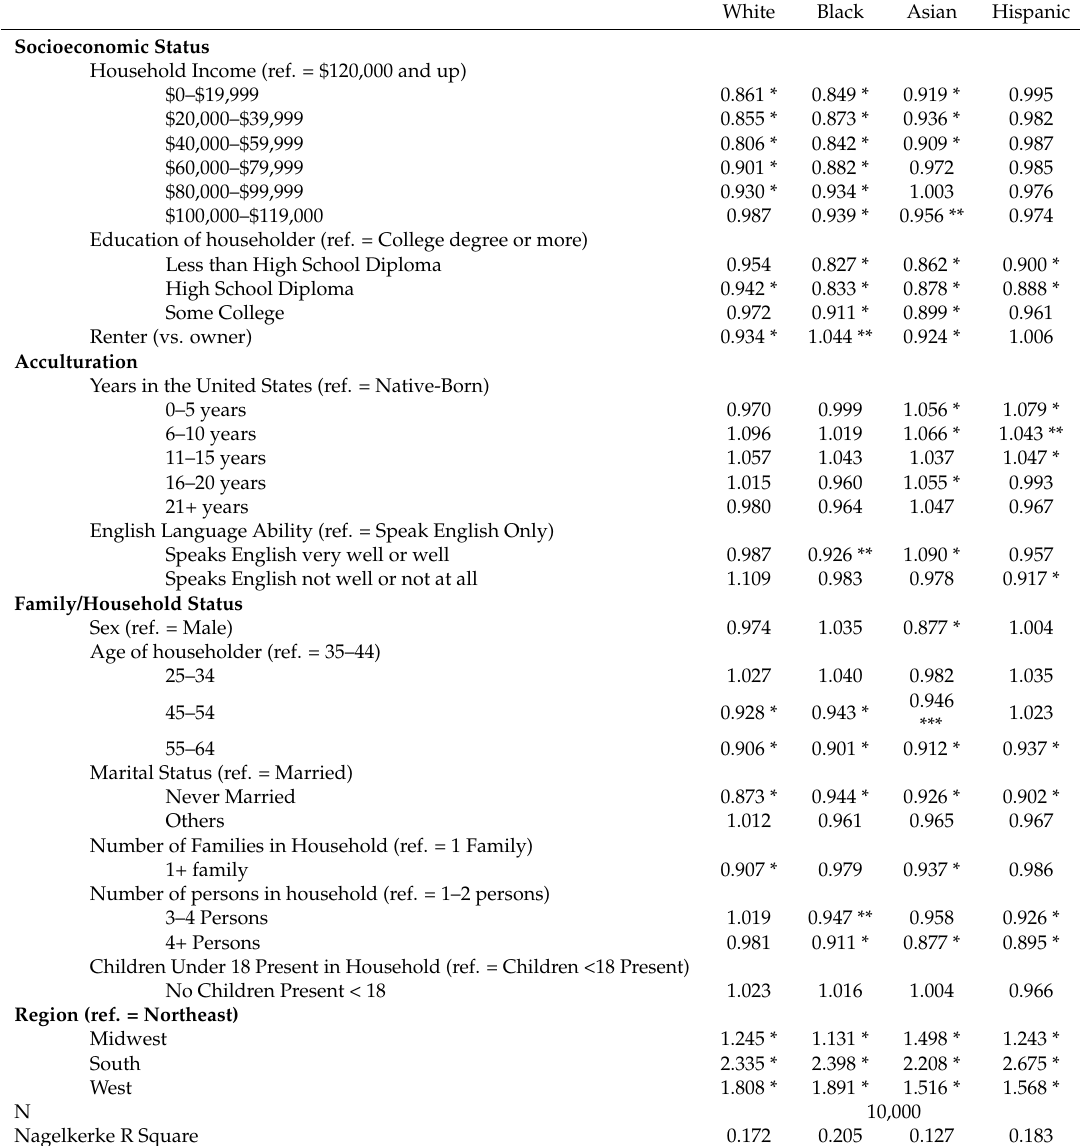
White Black Asian